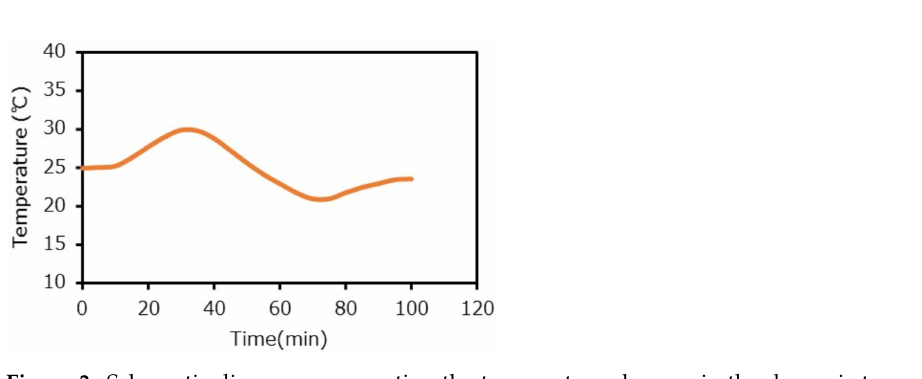
Figure 3. Schematic diagram representing the temperature changes in the dynamic temperature